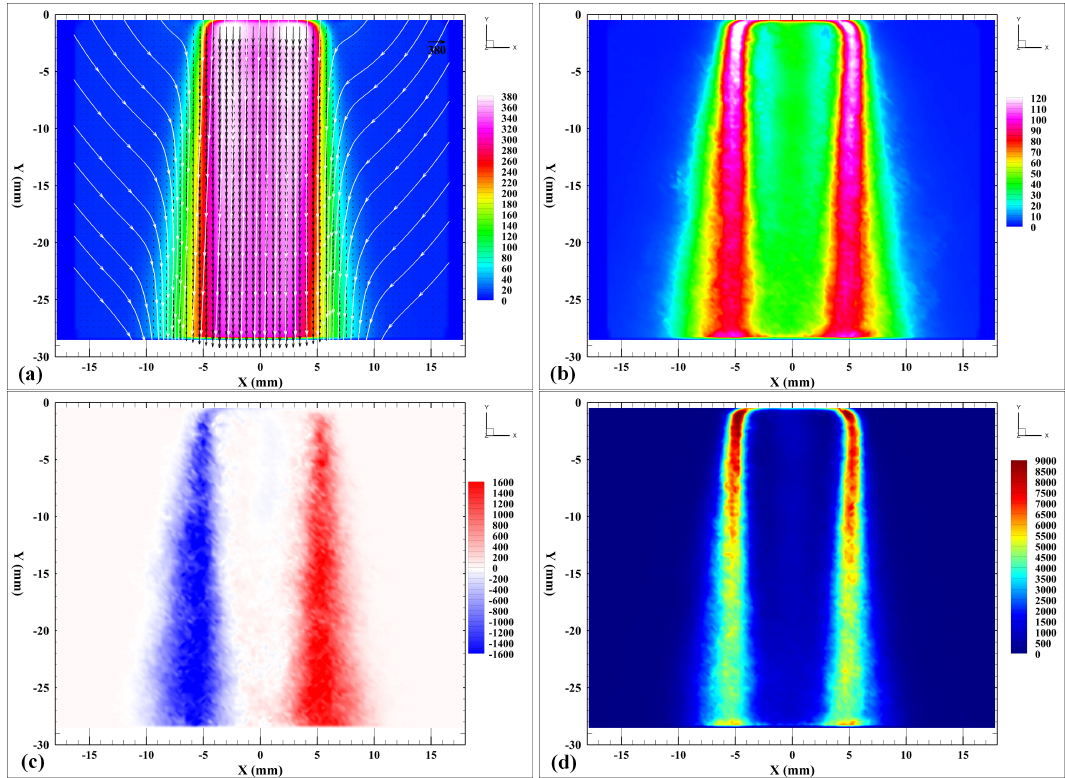
Figure 2. PIV results obtained from experimental measurements of under-expanded free jets at NPR 4 = 2.77. ( a ) Mean in-plane velocity field, color contour of velocity magnitude (m/s) and velocity streamlines, color contours of ( b ) RMS fluctuating velocity v (cid:48) rms (m/s), ( c ) Reynolds stress (cid:104) u (cid:48) v (cid:48) (cid:105) (m 2 /s 2 ), and ( d ) turbulent kinetic energy k (m 2 /s 2 ). Vectors were de-sampled for better